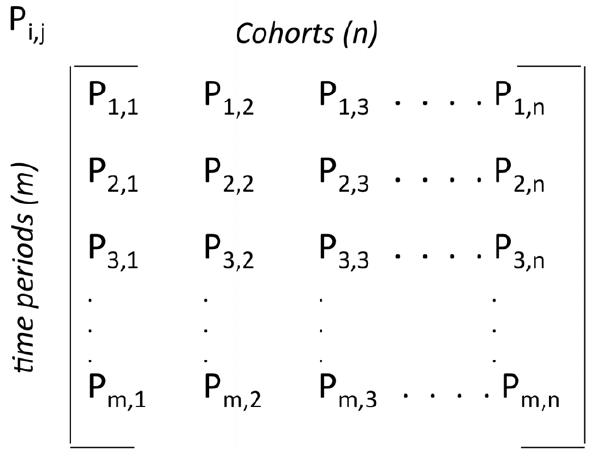
Figure 1. Design of platelet population matrix.